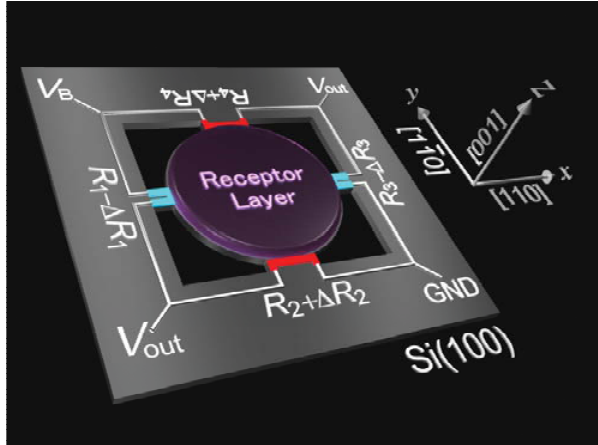
Figure 1. Schematic illustration of the MSS. The whole surface stress induced on the round center membrane is efficiently detected by piezoresistors (red and blue colored parts) embedded in the constricted beams. Note that the new MSS chip fabricated in the present study has a different arrangement of piezoresistors on the sensing beams, which is discussed in Section